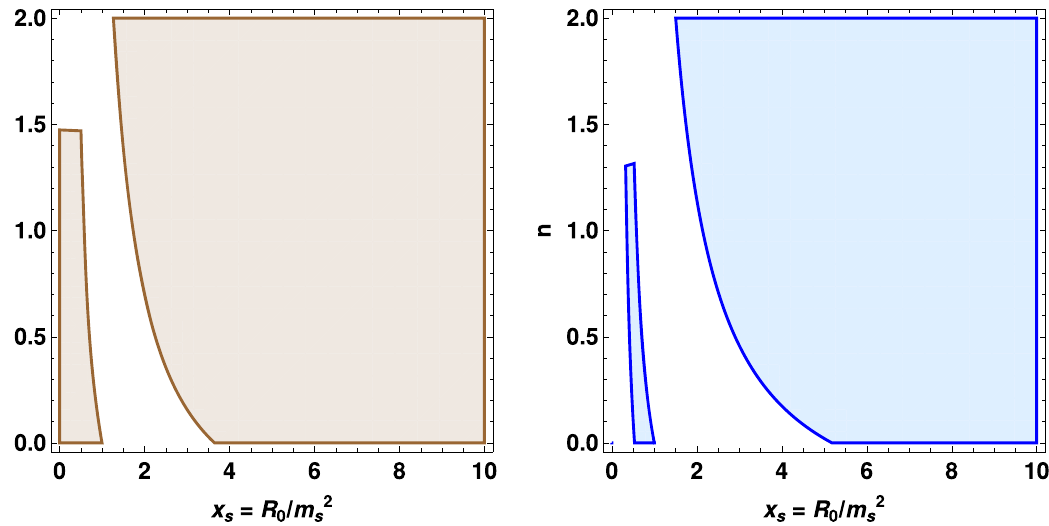
Fig. 11 Stability region of the Starobinsky model. Figure on the left side shows the stability region allowed by Eq. (46) and figure on the right side shows the stability region allowed by Eq. (47)